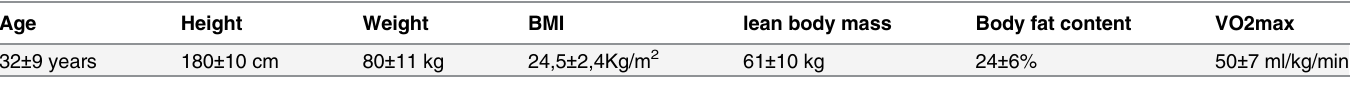
Table 1. Subject characteristics.